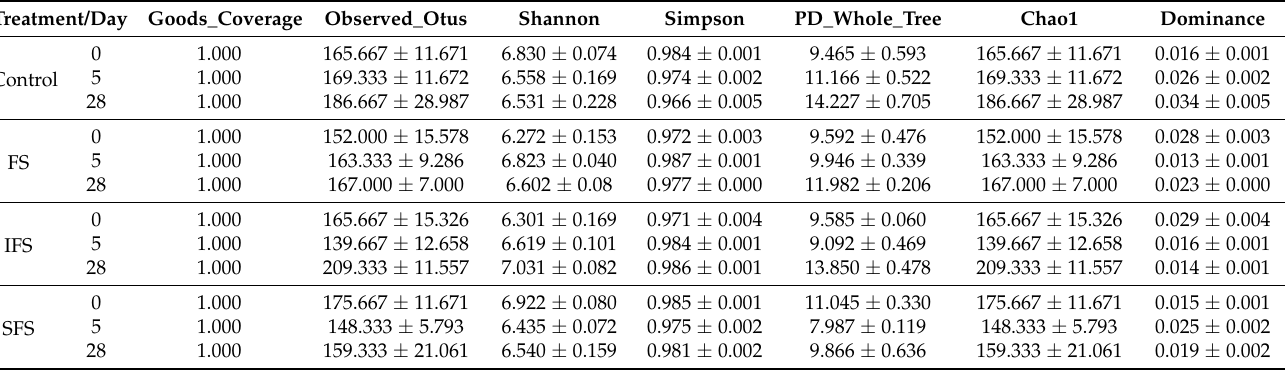
Table 3. The alpha diversity